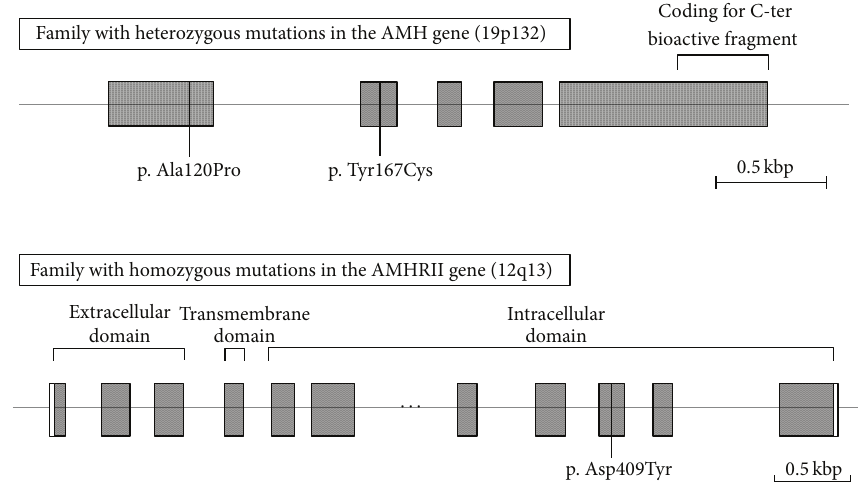
Figure 1: Mutations of the AMH gene (Case 1 ) and the AMH-RII gene (Case 2) in two families with boys presenting with PMDS. Two missense mutations in exons 1 and 2 (substitution of alanine by proline and of tyrosine by cysteine, resp.) were found in the AMH gene in two brothers presenting with AMH-negative PMDS. A homozygous missense mutation in exon 9 (substitution of aspartic acid by tyrosine) in the AMH-RII gene was found in two brothers presenting with AMH-positive